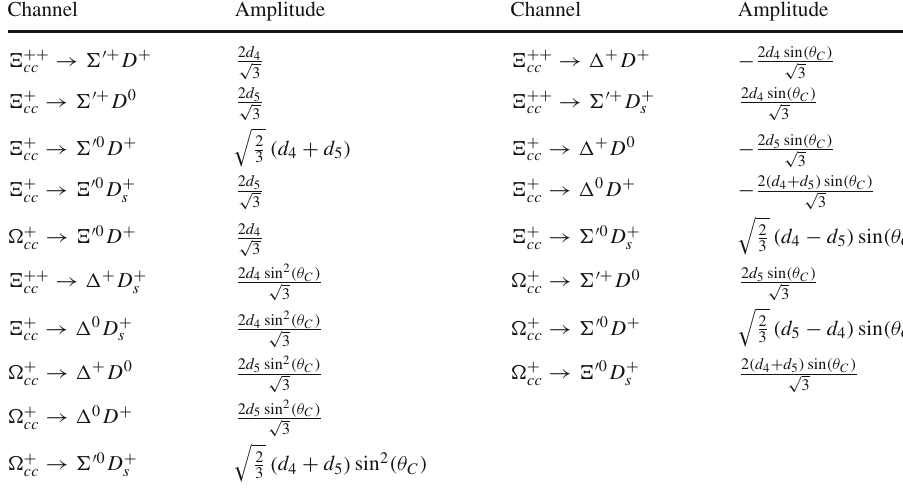
Channel Amplitude